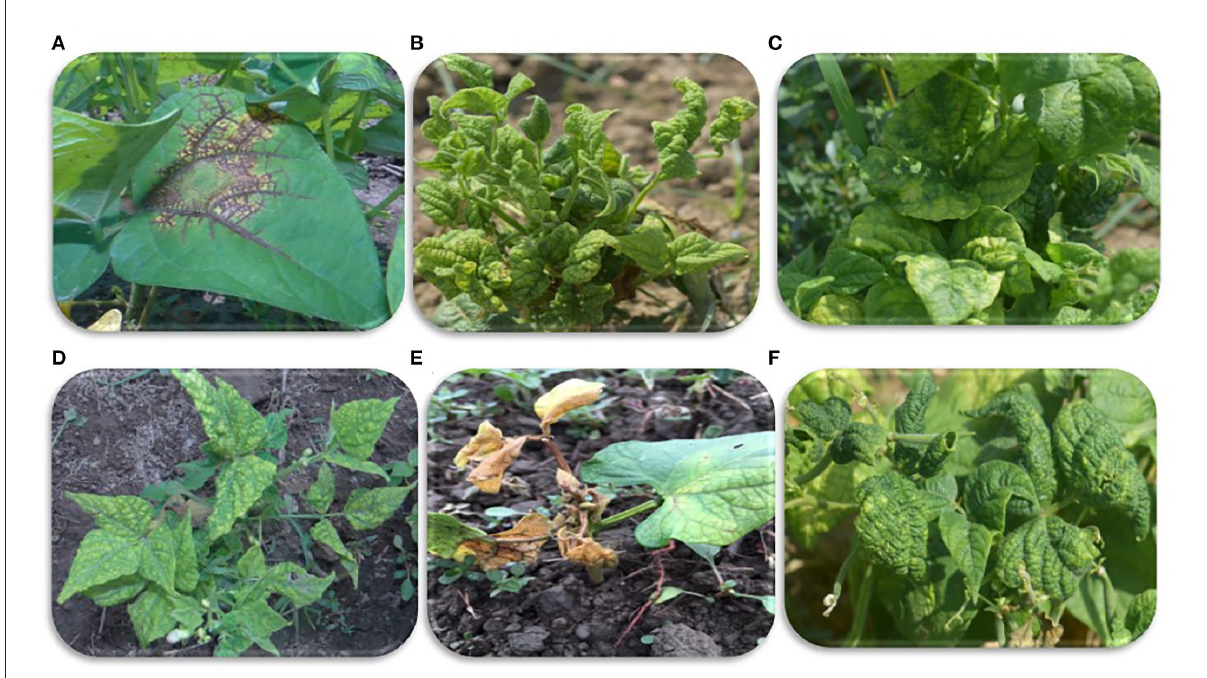
FIGURE1 Viral symptoms on common beans observed during sample collection. (A) Veinal necrosis. (B,D,F) Mosaic and severe leaf deformities, (C) mosaic and puckering, and (E) mosaic and leaf